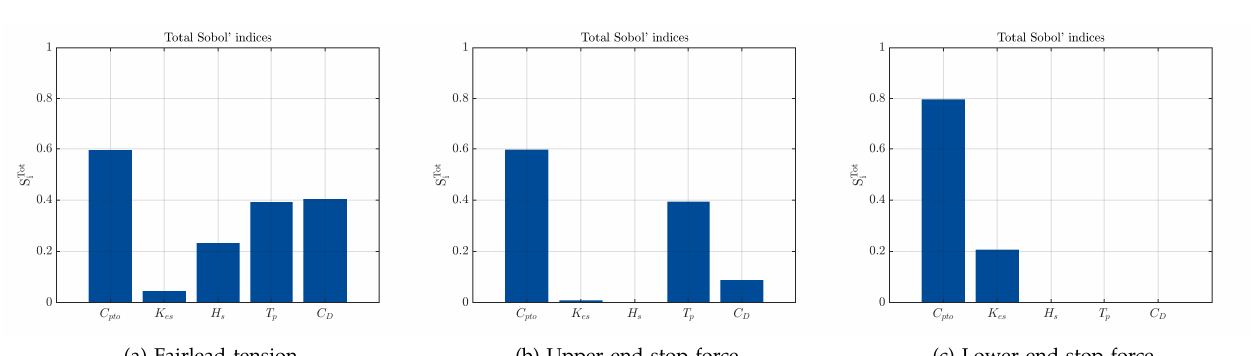
Fig. 9. PDFs for the ERW2 case using d = 5 .